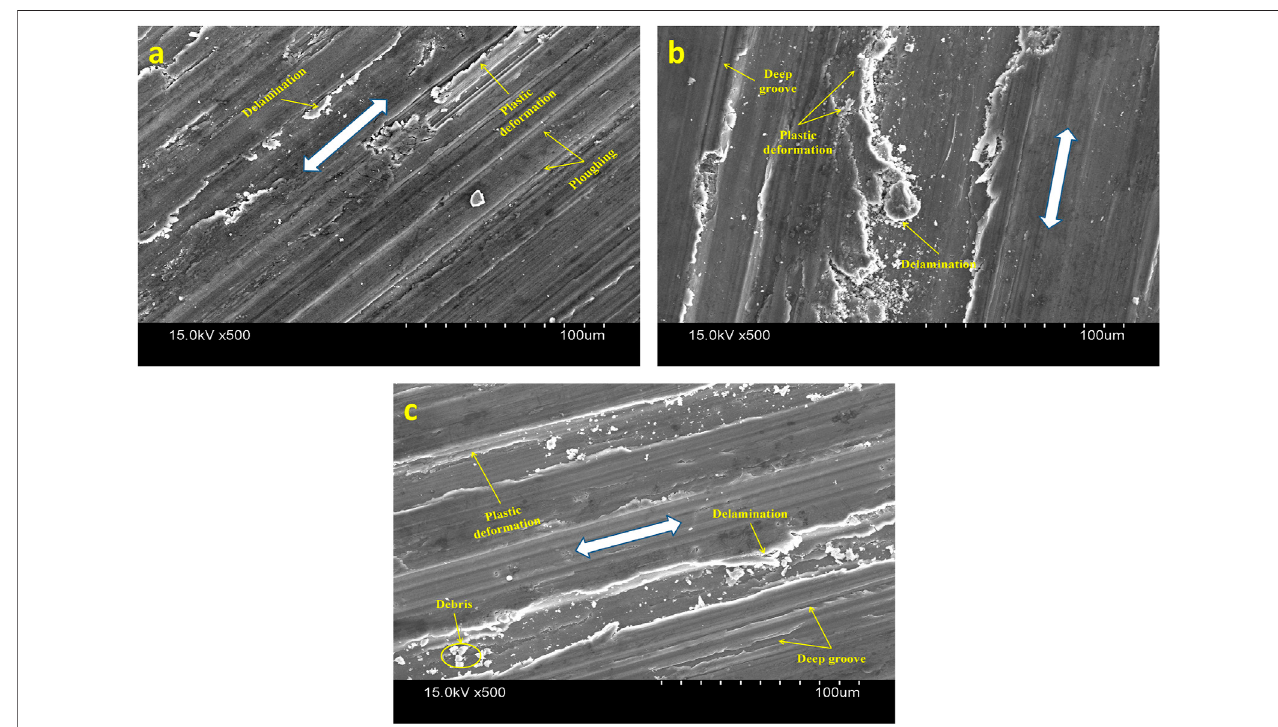
FIGURE 12 | SEM micrographs of samples tested at optimal conditions: (A) optimal condition of wear, (B) optimal condition of COF, and (C) optimal condition of multi-objective system.